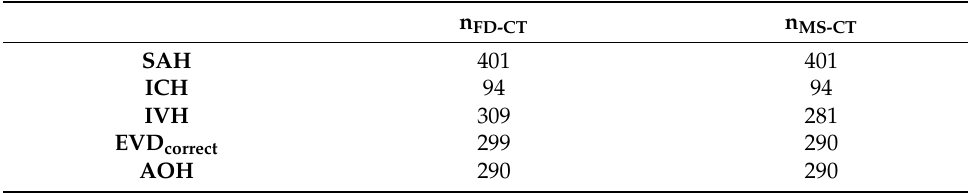
Table 3. Qualitative evaluation of blood distribution, EVD position and AOH in postinterventional FD-CT and